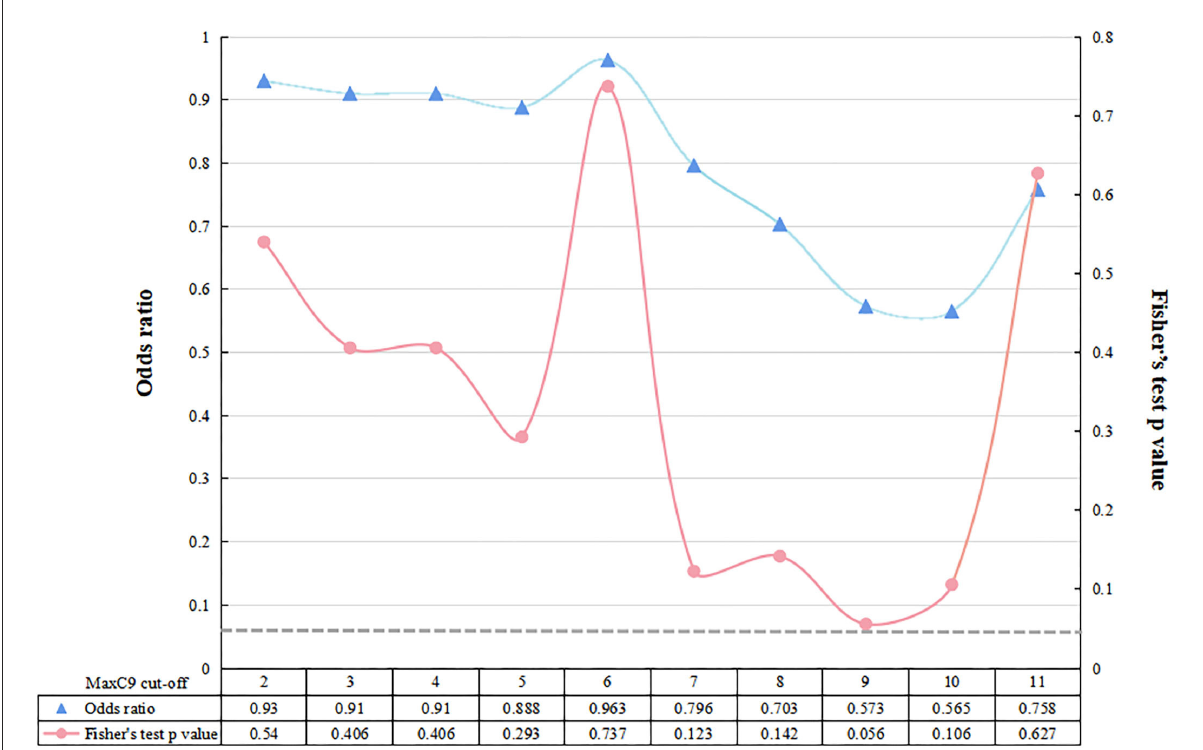
FIGURE2 Fisher’s exact test between patients with ALS and controls at each cutoff value of C9orf72 repeat. The dotted gray line represents the value of p < 0.05 at a significance level.